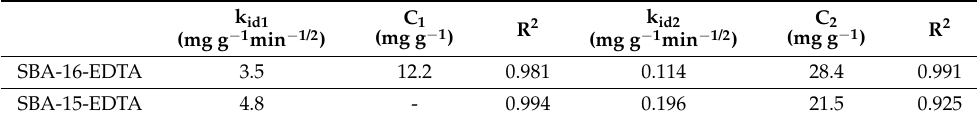
Table 3. Parameters of the intra-particle diffusion